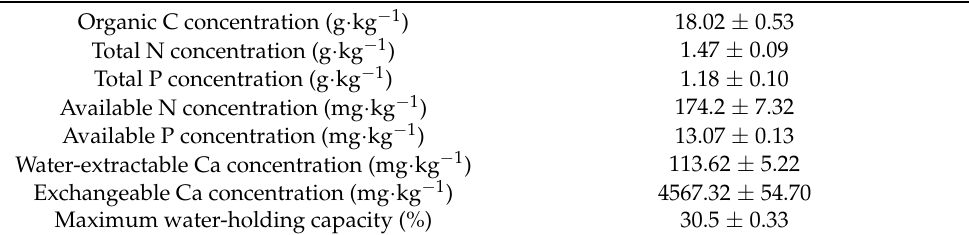
Table 1. Chemical characteristics of the nursery soil before